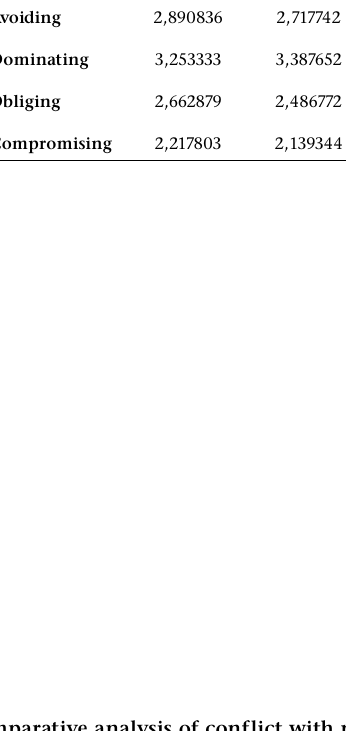
Figure 2: Comparative analysis of conflict with peer in both